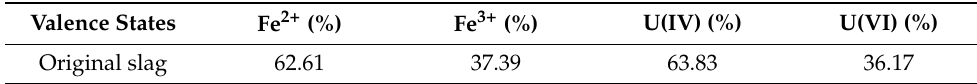
Table 4. XPS element analysis diagram of tantalum-niobium